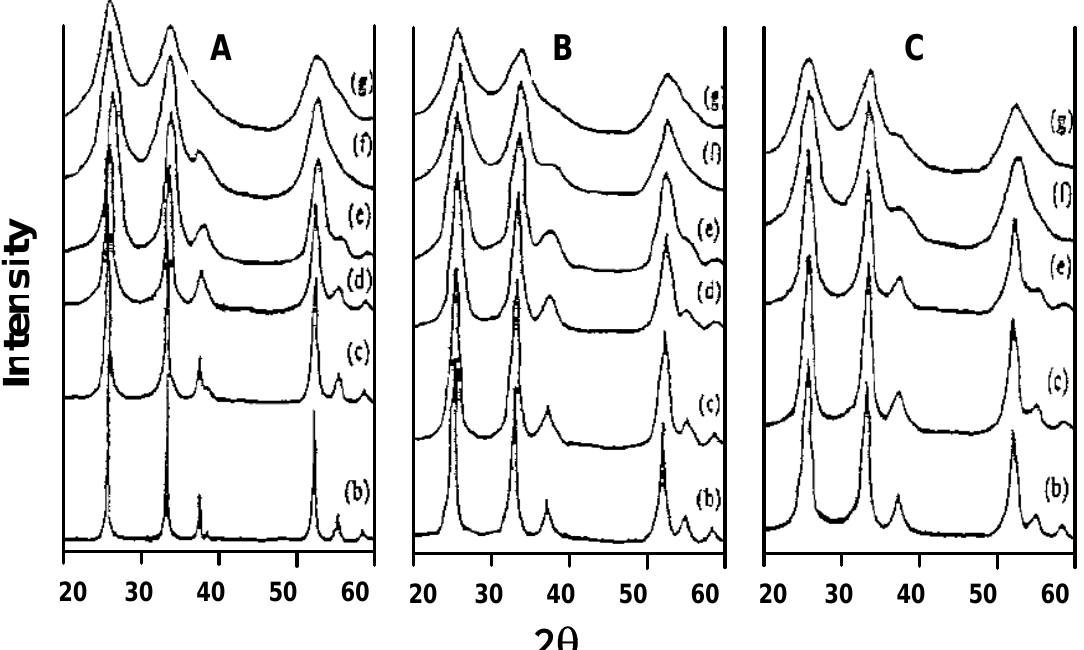
Figure 5. XRD patterns of SnO nanocrystalline powders, calcined for 2 h at (b) 800 ℃ , (c) 600 ℃ , (d) 500 ℃ , (e) 400 ℃ , (f) 300 ℃ and (g) 200 ℃